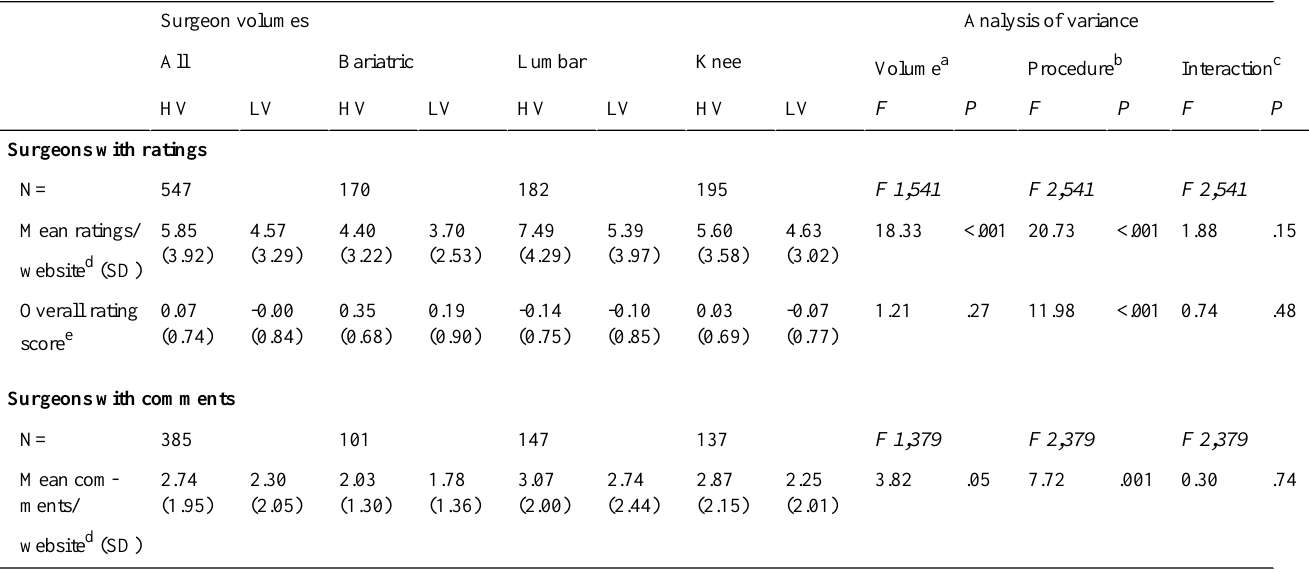
Table 6. Analysis of ratings and comments for high- and low-volume